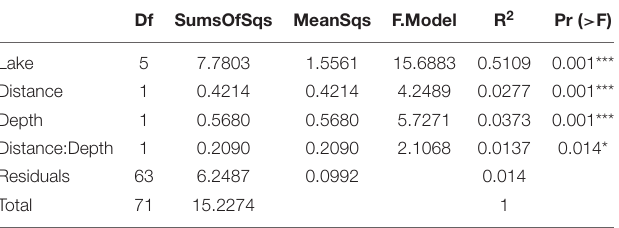
TABLE 3 | Spatial effects by PERMANOVA across six